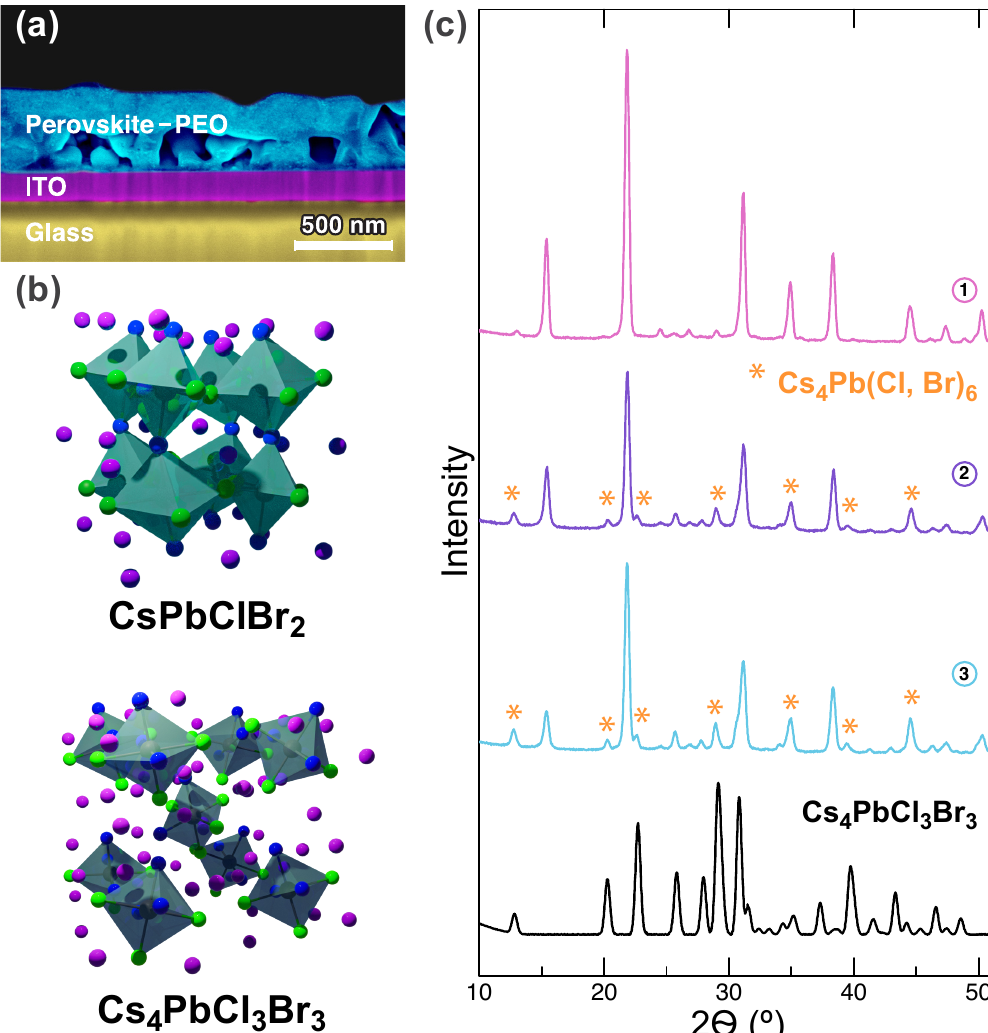
Figure 1. ( a ) SEM cross-sectional image of the perovskite-PEO film ( 1 ) on ITO substrate. ( b ) The crystal structure of an orthorhombic CsPbClBr 2 and rhombohedral Cs 4 PbCl 3 Br 3 phases. ( c ) XRD patterns of the samples 1 – 3 and reference Cs 4 PbCl 3 Br 3 -PEO film at room temperature. 1 shows diffraction peaks assigned to orthorhombic CsPb(Br,Cl) 3 perovskite [8]. The patterns of 2 and 3 reveal a mixture of orthorhombic trihalide phase and rhombohedral hexahalide phase (peaks are marked by stars) that is very similar to Cs 4 PbCl 3 Br 3